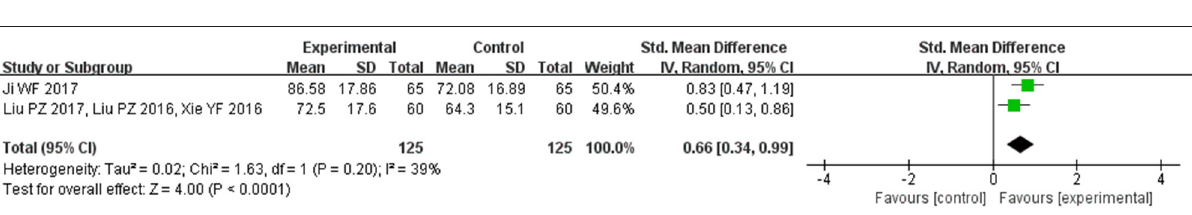
FIGURE 6 | Forest plot of the comparison between CHM and control for quality of life as measured by the